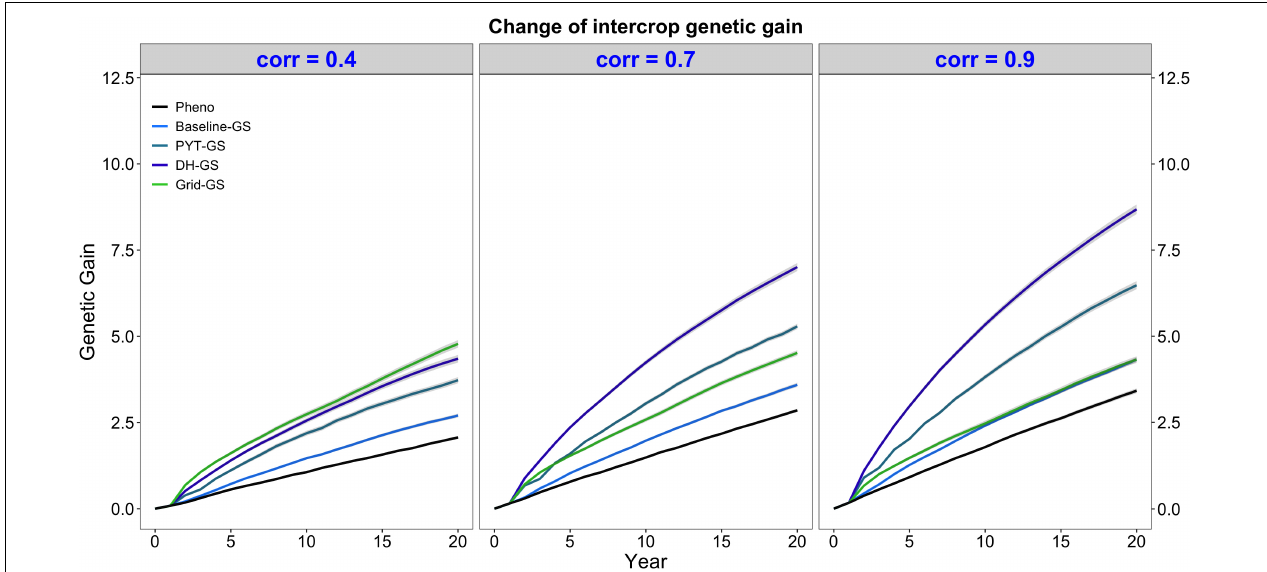
FIGURE 3 | Intercrop genetic gain over time for five simulated breeding programs. Results are shown under genetic correlations of 0.4, 0.7, and 0.9. Simulations are based on a medium annual operating budget (approx. United States $500K). Intercrop genetic gain is plotted as mean intercrop genetic value in the doubled haploid stage for the entire future breeding phase. The lines within each of the three panels represent the five breeding programs where each line represents mean genetic value for the 30 simulated replicates and the shadings show standard error bands. The black line represents the Phenotypic selection breeding program (Pheno), the blue-colored lines represent the three Conventional genomic selection breeding programs (Baseline-GS, the Baseline genomic selection breeding program; PYT-GS, the Preliminary yield trial genomic selection breeding program; DH-GS, the Doubled haploid genomic selection breeding program) and the green-colored line represents the Grid genomic selection breeding program